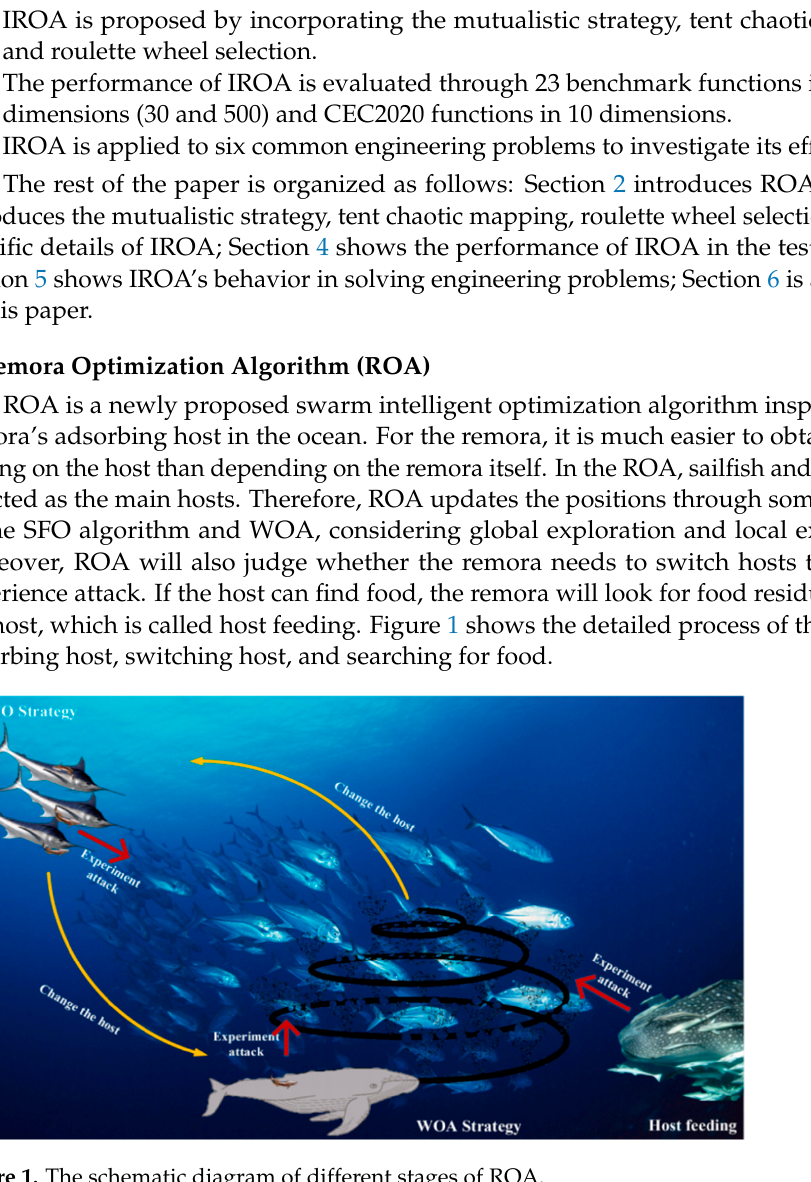
Figure 1. The schematic diagram of different stages of ROA.